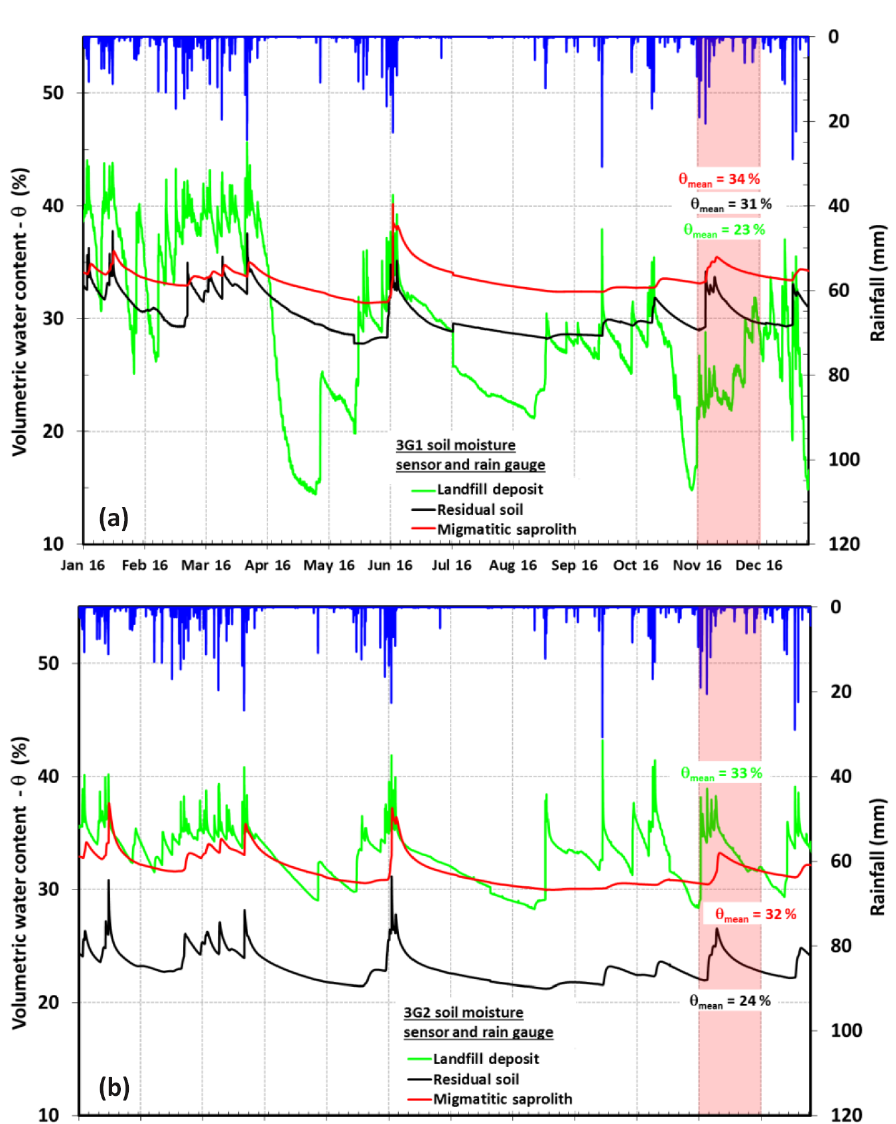
Figure 9. Time variation of soil moisture at different depths during 2016 in the study area measured with the sensors 3G1 (a) and 3G2 (b)